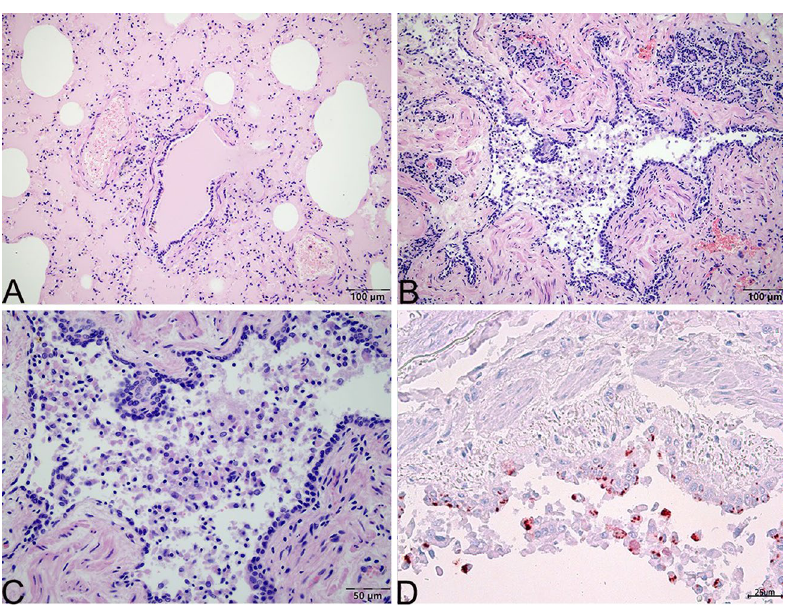
Figure 4. Microscopic change of lung of Case 2. ( A ) Pulmonary alveoli are distented and filled with pink exudate. ( B ) Many lymphocytes and exfoliative cells fill the bronchioles. ( C ) Local enlargement of ( B ). There are no viral inclusion bodies in the epithelial cells of the bronchiole mucosa in the lung tissue. ( D ) Positive signal (red) of FHV-1 is primarily located in the cytoplasm of epithelial cells of bronchioles and exfoliative cells by immunohistochemistry stain. ( A ), ( B ), and ( C ) stained using haematoxylin and eosin (H&E). ( D ) stained by the mouse anti-FHV-1 antibody. Captured by Olympus CX 43 microscope and EPview Ver 1.2. www. olymp us- sis.